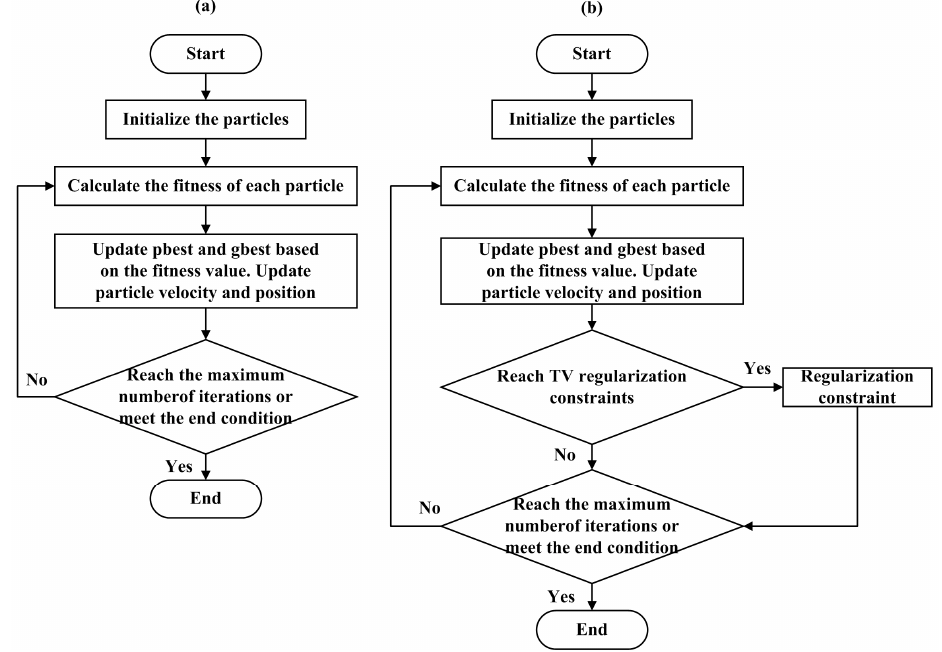
Figure 5. Flow charts for the algorithms: ( a ) COPSO algorithm; ( b ) proposed TVIPSO algorithm.